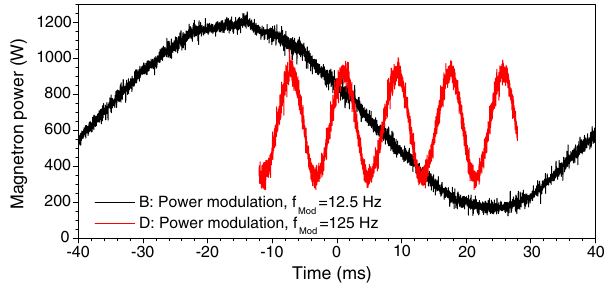
FIG. 11. Modulation of the magnetron power managing the magnetron current by a harmonic signal controlling the SM445G HV switching power